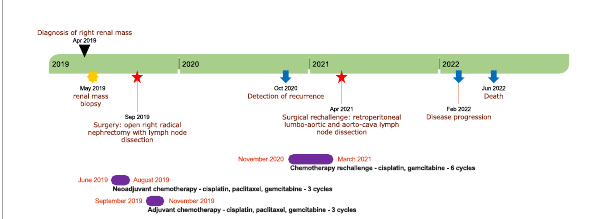
FIGURE 3 A timeline depicting patient care with the main notable events during follow-up. The timeline is represented by a green stripe divided into years. The black triangle indicates the date of diagnosis; the yellow star denotes the timing of renal mass biopsy; the red stars indicate the timing of surgeries; the blue arrows denote the timing of recurrence and death; and the violet stripes represent periods of